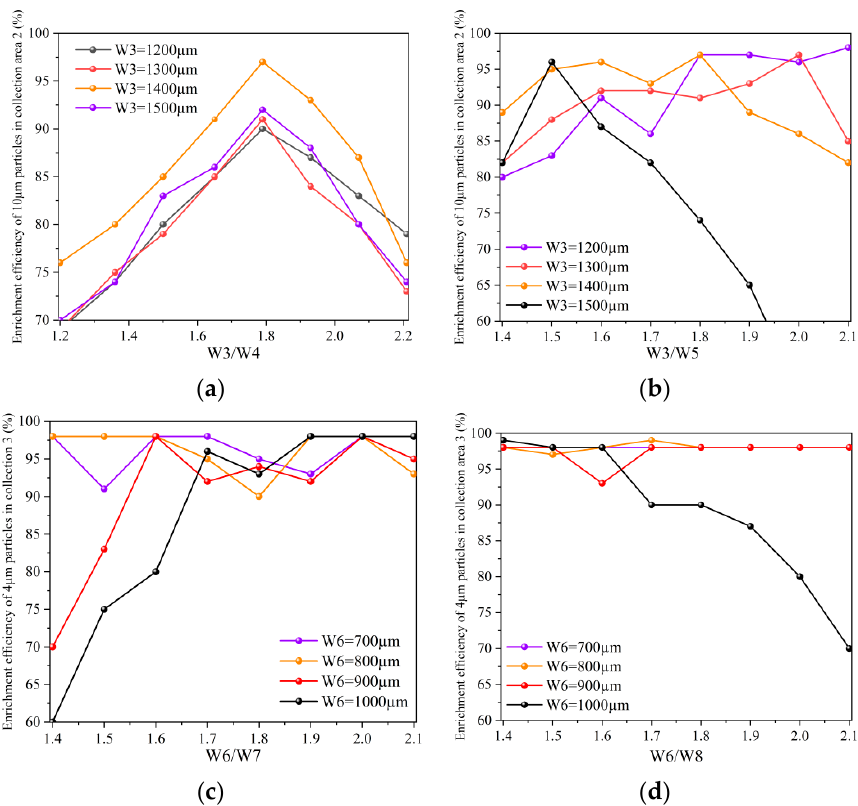
Figure 4. Chip simulation results ( a ) Collection efficiency corresponding to different W3/W4 ratios, ( b ) Collection efficiency corresponding to different W3/W5 ratios, ( c ) Collection efficiency corresponding to different W6/W7, ( d ) Collection efficiency corresponding to different W6/W8.